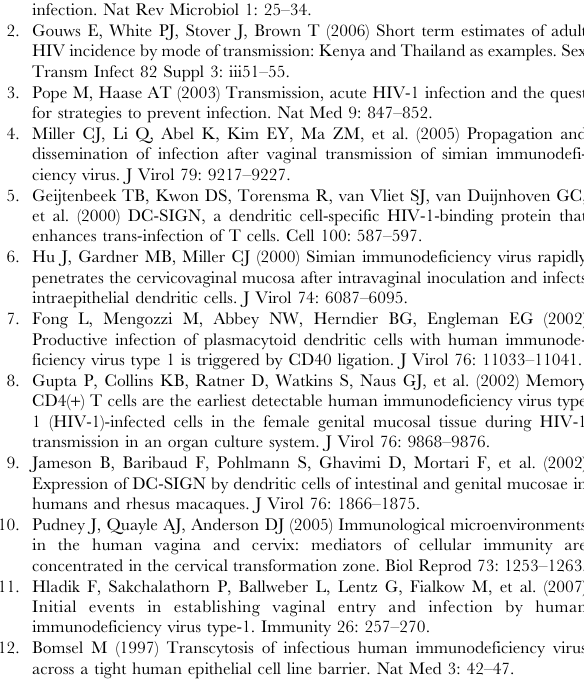
Figure S1 PPAR c and LXR ligand treatment do not alter MDDC viability. Immature MDDCs were treated for 48 hours with 100 m M ciglitazone or 1 m M TO-901317. Cell viability was assessed by the release of LDH into the cell culture supernatant.